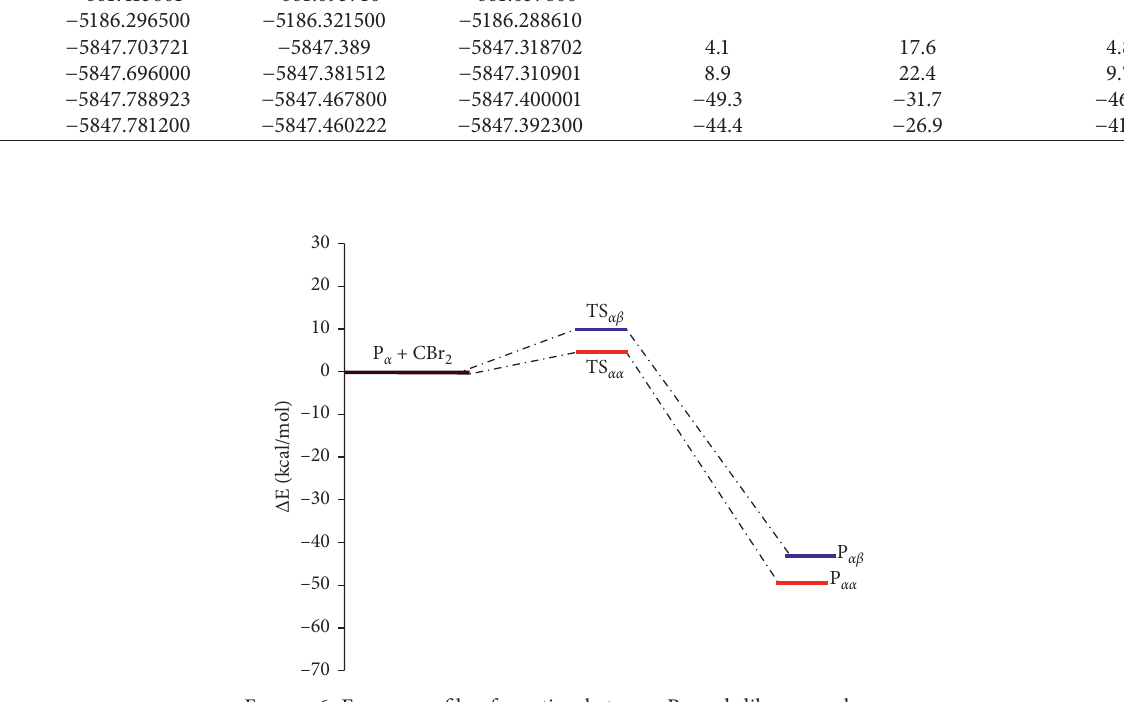
α and dibromocarbene.